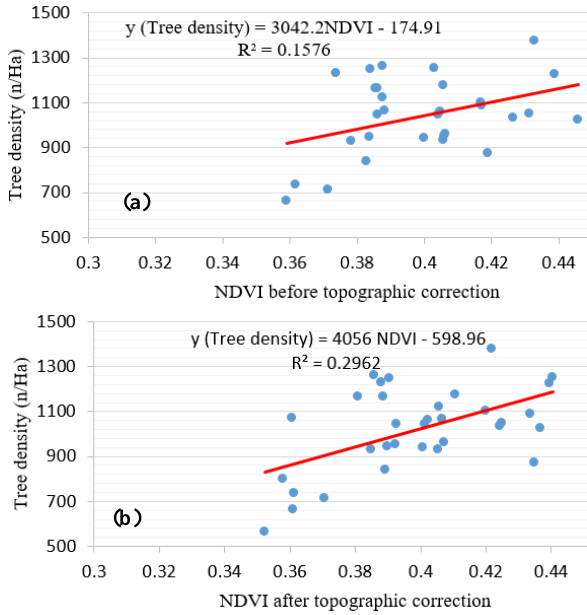
Figure 12. Regression between tree density and NDVI, (a) before and (b) after topographic correction